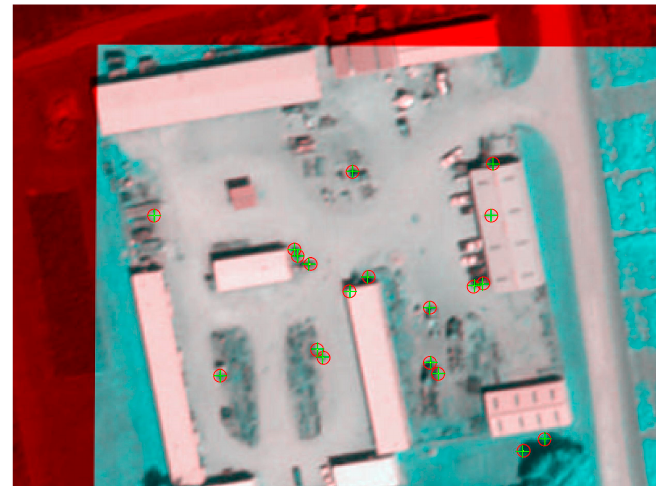
Figure 9. Overlap of the reference image in the bottom (NIR image) with the sensed image on the top (RGB image) with affine transformation, based on the FAST matched points. The red circles indicate the feature points on the NIR image and the green plus signs represent those on the RGB image. The red and green point pairs shown in this figure were the correct matching pairs, after elimination by m- estimator sample consensus (MSAC).